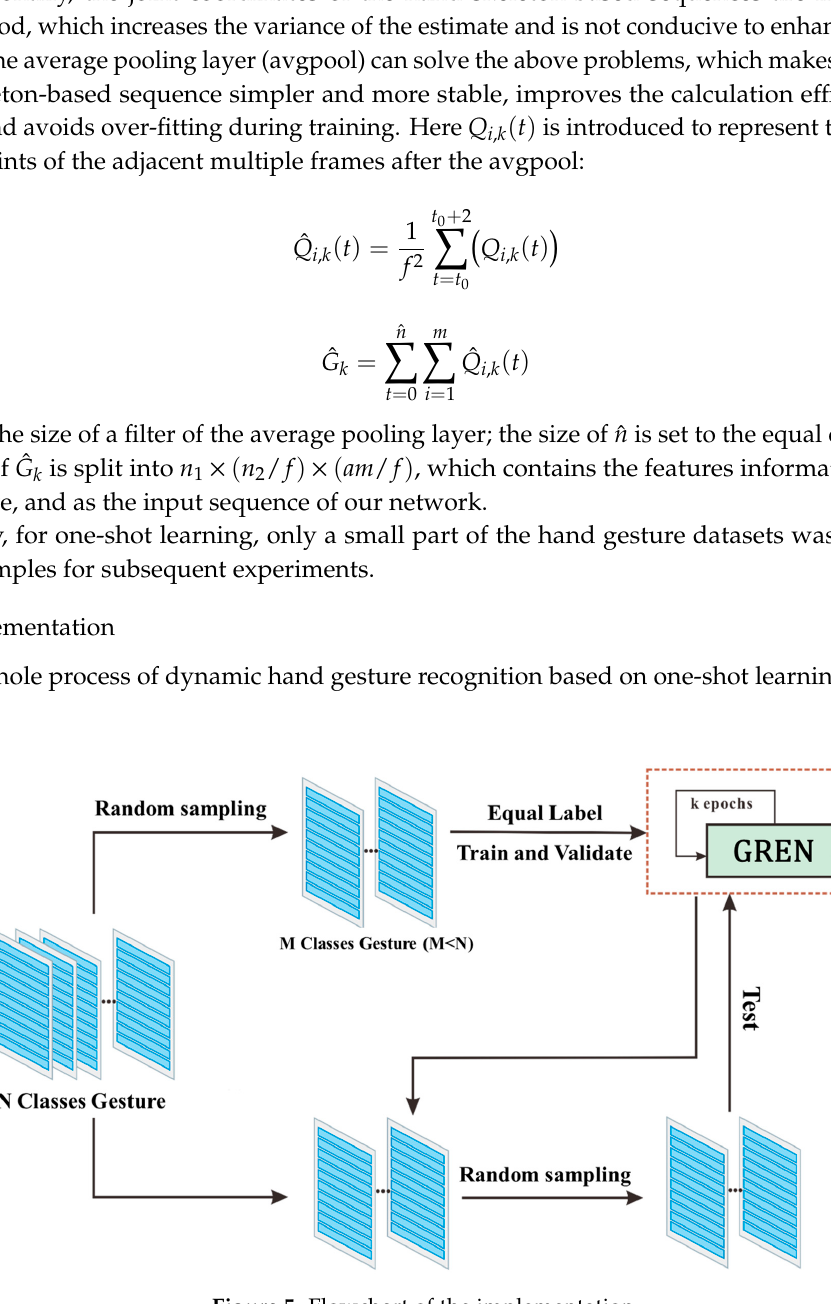
Figure 5. Flowchart of the